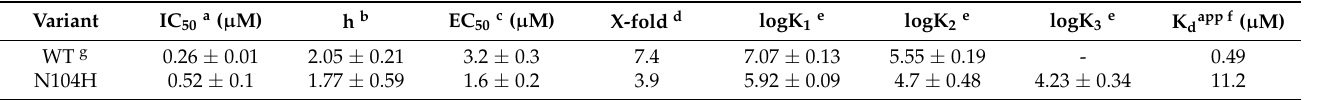
Figure 4. Ca 2+ -dependent Guanylate Cyclase (GC) regulation by GCAP1 variants. ( A ) Membranes containing GC were reconstituted with 5 µ M WT or N104H-GCAP1 and <19 nM Ca 2+ (black) or ~30 µ M free Ca 2+ (grey); control data were obtained using membranes without addition of GCAP1; reported data refer to average ± standard deviation of 6 technical replicates. ( B ) GC activity as a function of N104H-GCAP1 concentration (0 - 10 µ M) in the presence of <19 nM Ca 2+ . ( C ) GC activity as a function of Ca 2+ concentration (<19 nM - 1 mM) in the presence of 5 µ M N104H-GCAP1. The physiological window of variation in Ca 2+ concentration in photoreceptors is represented by the grey-shaded area. Measured enzymatic parameters are reported in Table 1. Table 1. Enzymatic regulation and Ca 2+ -affinity of GCAP1 variants. a [Ca 2+ ] at which GCs activity is half-maximal; b Hill coefficient; c [N104H] at which GCs activity is half-maximal; d calculated as (GC max -GC min )/GC min , where GC max and GC min represents the maximal and minimal cGMP production; e decimal logarithm of the macroscopic Ca 2+ -binding constants after data fitting to a three independent binding sites model obtained with CaLigator [31]; f apparent affinity values calculated after averaging logK i ; g WT data are taken from Ref.